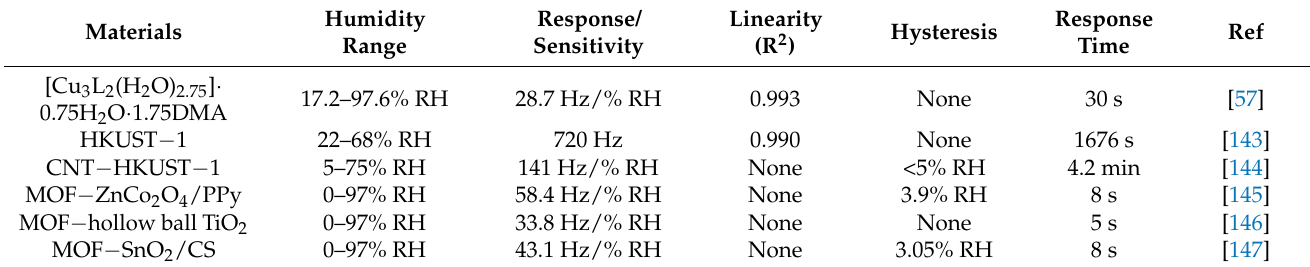
Table 5. Sensing properties of MOF − based QCM − type humidity